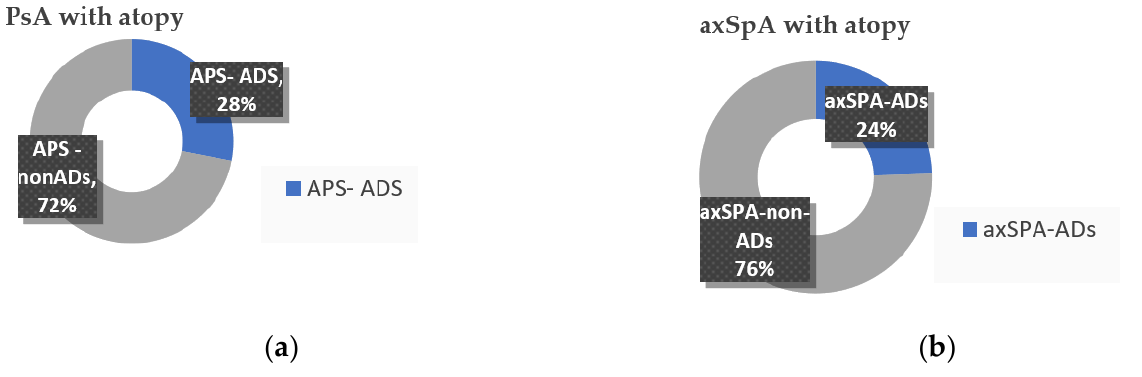
Figure 1. SpA patients with and without atopy: ( a ) PsA; ( b ) axSpA; ADs, atopic disorders.